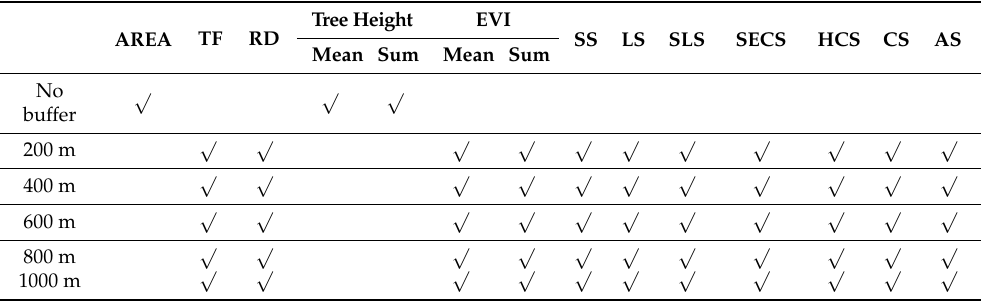
Table A2. The variables for analyzing the attractiveness of the park’s